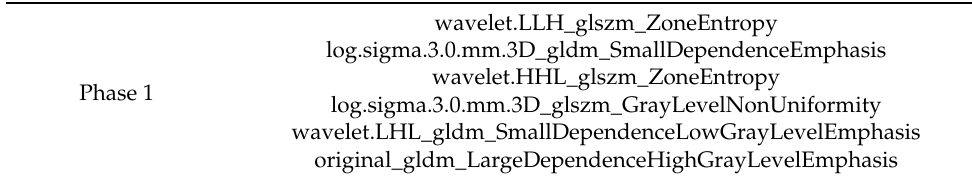
Table 2. Radiomic features for each time